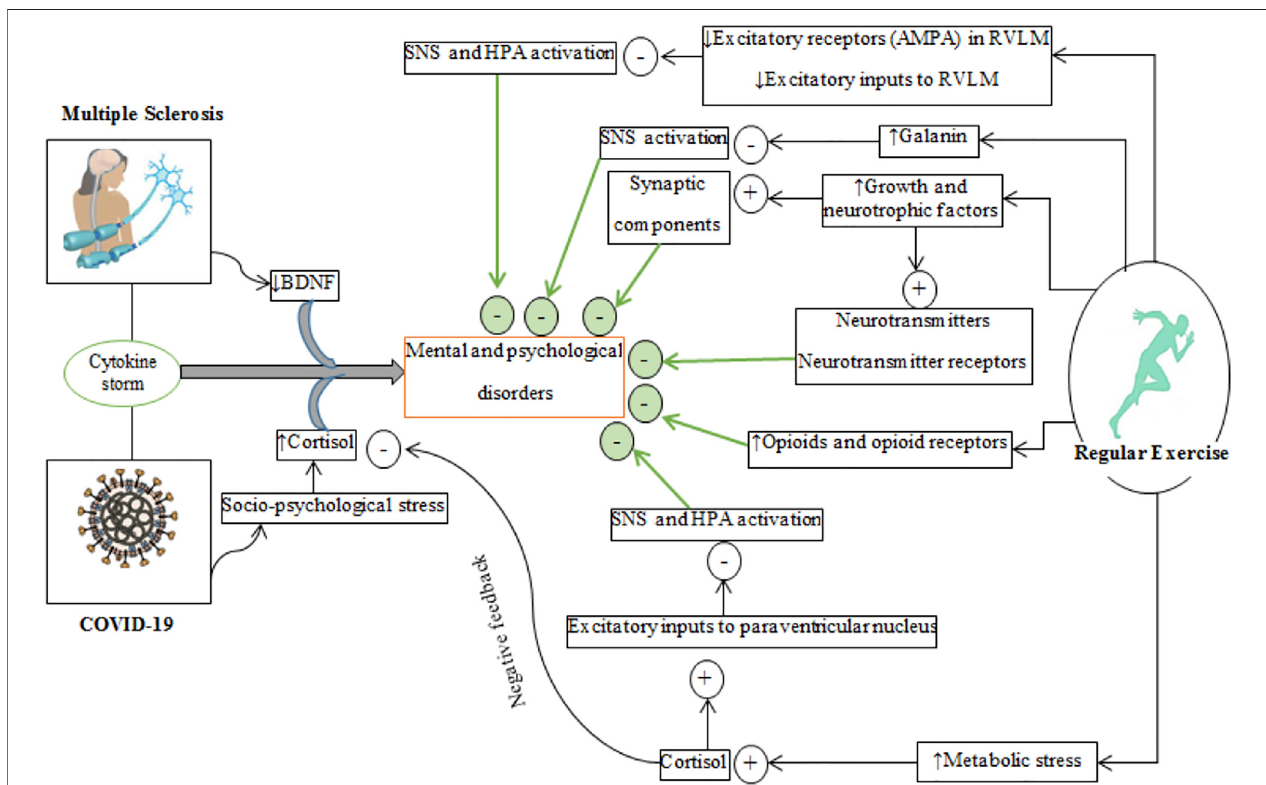
FIGURE 3 | Schematic representation of converged pathways associated with mental and psychological disorders at (left side) and regular exercise that inhibit these disorders (right side) in multiple sclerosis and COVID-19. Plus (+) marks represent the incremental effects of exercise while minus ( − ) marks represent decreased effects of exercise. The effects of regular exercise are shown by thick green arrows. HPA, hypothalamus-pituitary-adrenal axis; SNS, sympathetic nervous system; BDNF, brain-derived neurotrophic factor; AMPA, α -amino-3-hydroxy-5-methyl-4-isoxazolepropionic acid; RVLM, rostral ventrolateral medulla.